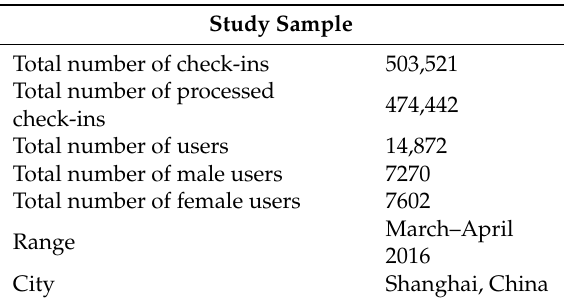
Table 1. Shanghai dataset details.